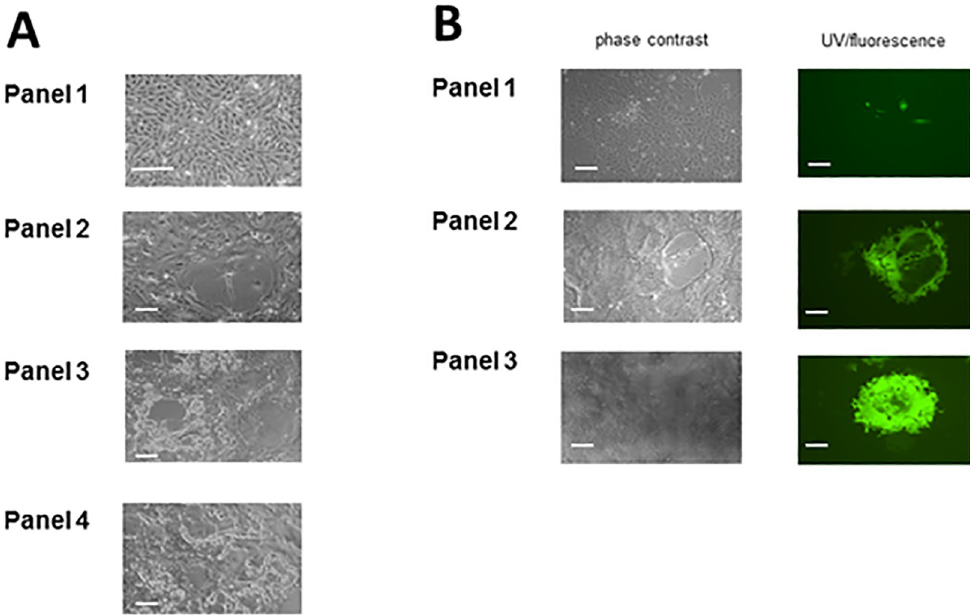
Fig 2. Rescue of the viruses as replicators; cpe and fluorescent plaques. A: Generation of rMuV G09 by reverse genetics. Panel 1 shows mock infected Vero cells; panel 2 shows the presence of primary foci of rescue at 5 days post transfection; panel 3 shows primary syncytia which were plaque picked and subsequently Vero cells were infected with the aspirated virus stocks. CPE was detected 1–2 dpi. Panel 4 shows plaque picked rMuV G09 grown for 4 low MOI passages on Vero cells. All show characteristic syncytium-formation (scale bar is 50 μ ). B: Generation of rMuV G09 expressing EGFP— rMuV G09 EGFP(3)—by reverse genetics. Panel 1 shows the presence of primary foci of rescue at 5 days post transfection in both phase contrast and UV microscopy; panel 2 shows primary syncytia which were plaque picked and subsequently Vero cells were infected with the aspirated virus stocks. EGFP expression was evident 1 dpi and cpe was detected 1–2 dpi. Panel 3 shows plaque picked rMuV G09 EGFP(3) grown for 4 low MOI passages on Vero cells. Passaged virus images show characteristic syncytium formation (scale bar is 50 μ ).